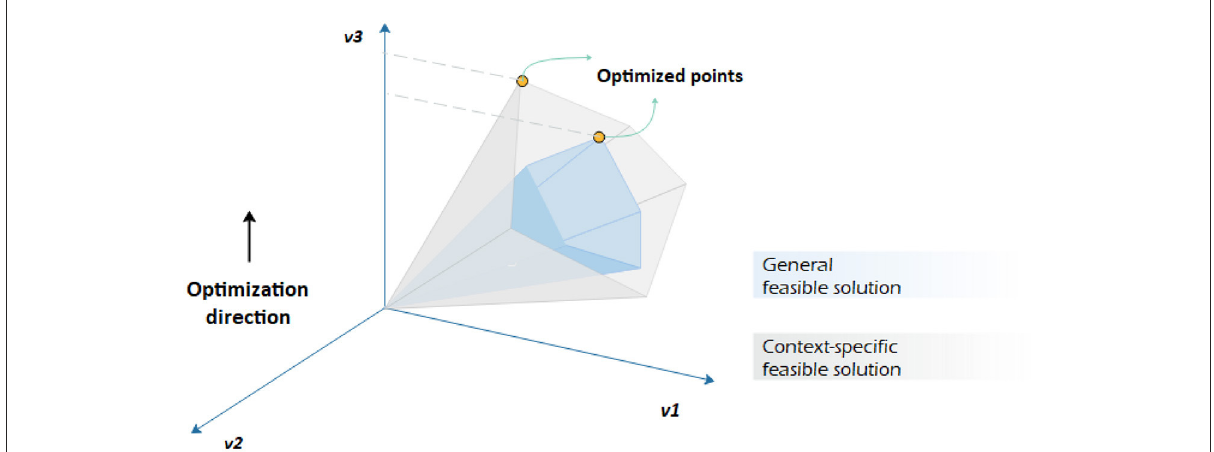
FIGURE3 Constraint-based analysis by imposing different constraints on the same genome-scale metabolic network. It is assumed that v 3 is to be maximized. Having a context-specific genome-scale metabolic model leads to a different convex-cone feasible solution with a different flux